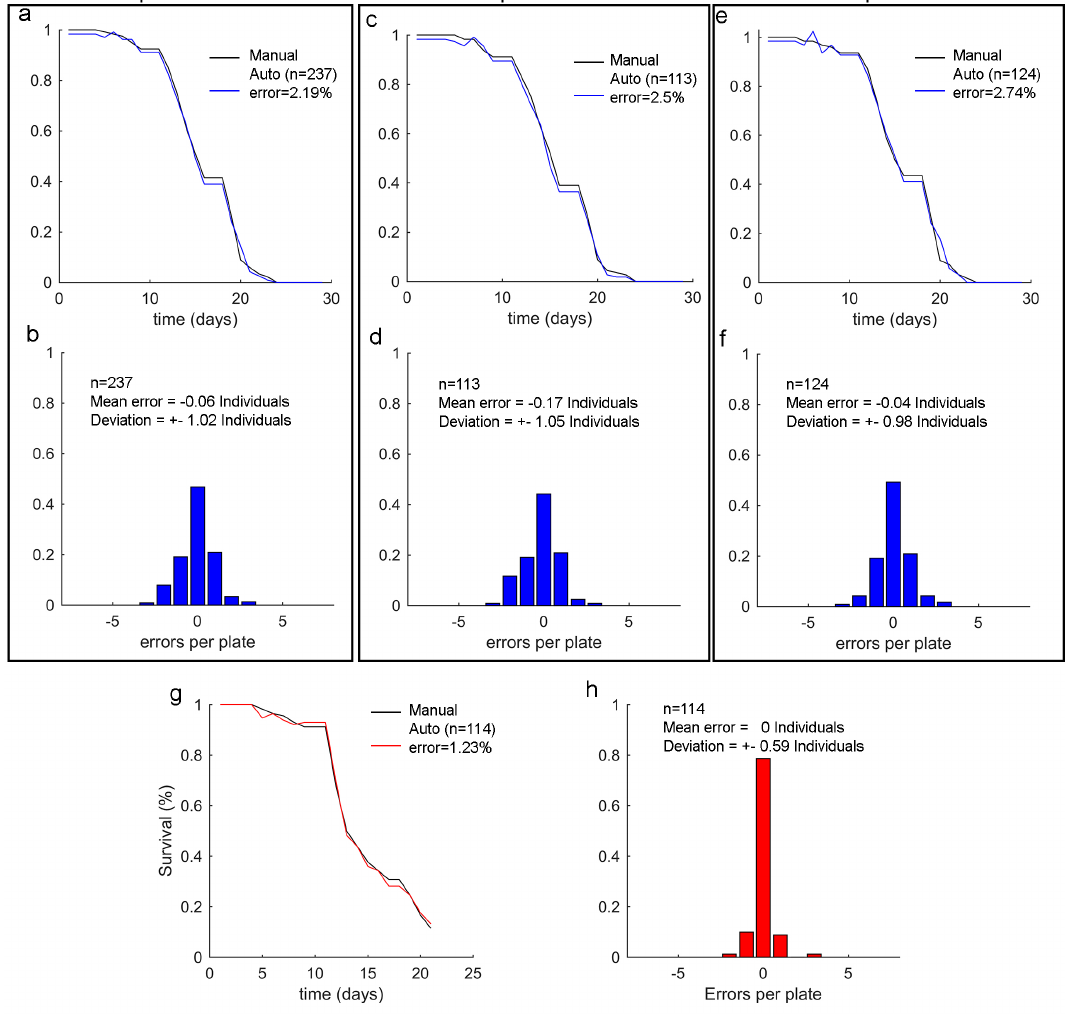
Figure 9. Lifespan results of experiment 3. ( a – f ) belong to the NVcondition . ( a ) is the survival curve as a percentage per one for all the replications. ( b ) is the error distribution per plate for all the replications. ( c , d ) are replication 1.( e , f ) are replication 2. ( g , h ) belongs to vibration condition V ( d 5 − t 3 ) . . As previously mentioned, experiments 1 and 2 were performed to define vibrations d and t